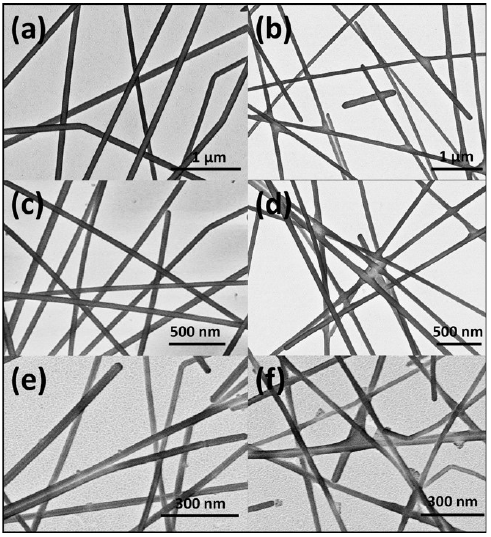
Figure 4. Scanning electron microscopy (SEM) images of transparent electrodes fabricated from ( a , b